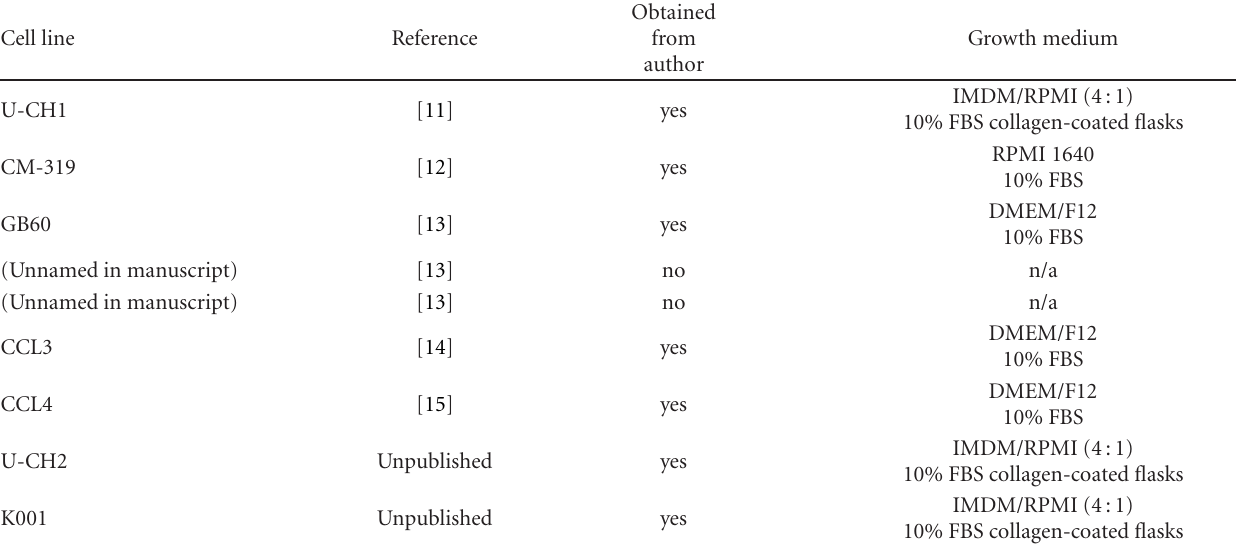
Table 1: Publications of human chordoma cell lines and their growth